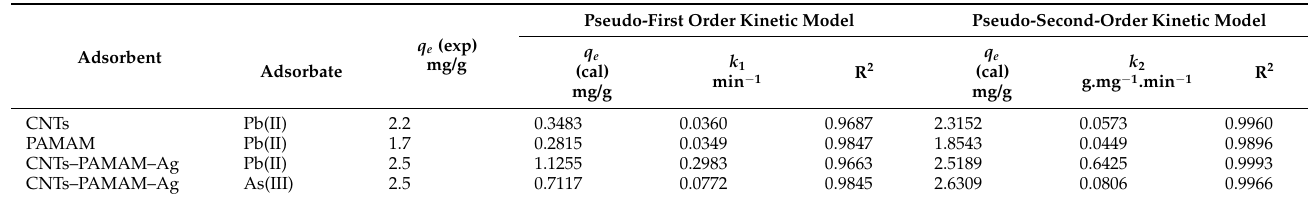
Table 1. Parameters calculated from pseudo-first, and second-order kinetic models.